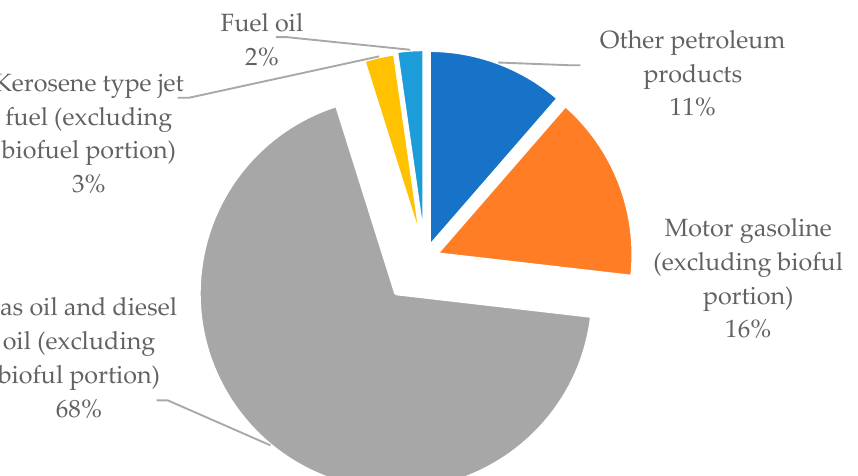
Figure 23. Portuguese energy balance flow for oil and petroleum products vector in final energy consumption–2019 data (adopted from Eurostat data). Regarding the use of natural gas, through the creation of the energy balance flow (presented in Figure 24), it was possible to disaggregate its use according to each activity. The industry sector is the sector with the largest penetration of this vector, especially the non-metallic minerals industry, mainly due to the heat of limestone and clay in the ceramic and glass industry. The electrification of the industry sector is possible, considering the proposed horizon for the total decarbonization of the energy sector by 2050, however, measures will be needed to overcome the main barrier in this sector, the supply of electricity from renewable sources 24/7, throughout the year, due to its intermittency. For this need, the development of electrical energy storage applications should be a priority.